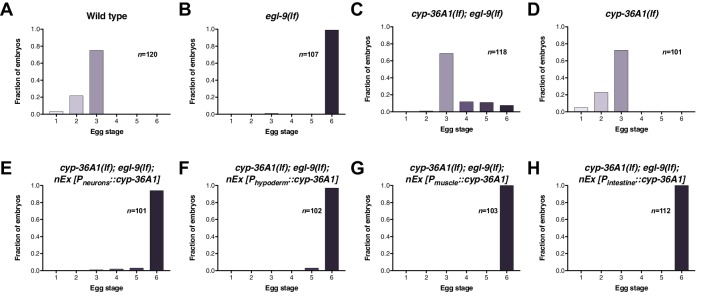
cyp-36A1 expression in multiple tissues rescues the egg-laying phenotype of cyp-36A1(lf); egl-9(lf).(A–H) Distribution of stages of eggs laid by adult hermaphrodites of the indicated genotypes. All strains contained the agIs219 (PT24B8.5::gfp) transgene. (A) Stages of eggs laid by wild-type animals. (B) egl-9(sa307) animals laid later stage eggs than wild type (p<0.001, Chi-square test with Holm-Bonferroni correction). (C) cyp-36A1(gk824636) suppressed the egg-laying defect of egl-9(sa307) mutants (p<0.001). (D) Stages of eggs laid by cyp-36A1(gk824636) single mutants were not significantly different from those laid by wild-type animals (p>0.05). (E–H) Expression of cyp-36A1(+) specifically in neurons, hypoderm, muscle, or intestine of cyp-36A1(gk824636); egl-9(sa307) animals all rescued the suppression by cyp-36A1(lf) of the egg-laying defect of egl-9(lf) (p<0.001).